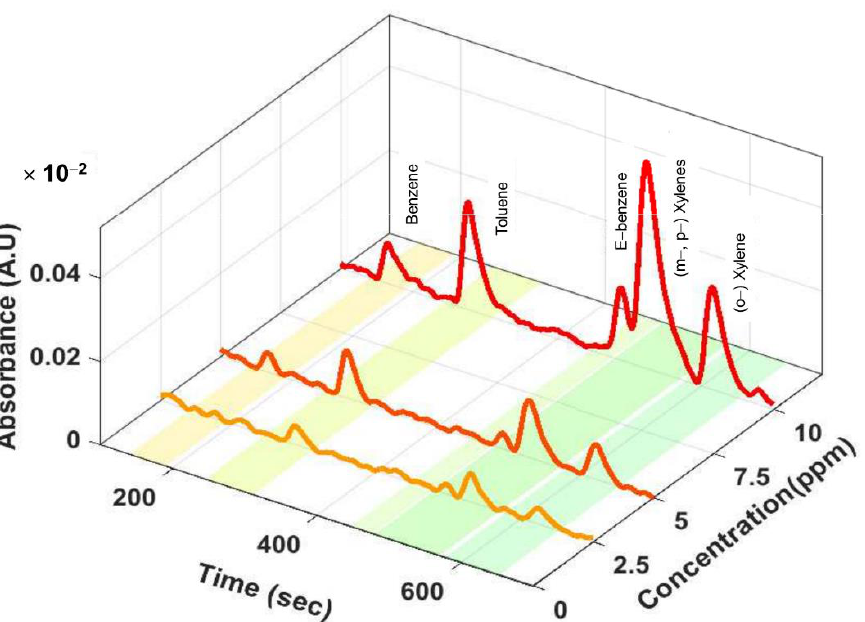
Figure 7. Chromatograms obtained for the toluene-N 2 concentration of 10 ppm, 5 ppm, and 2.5 ppm at column temperature 60 °C.